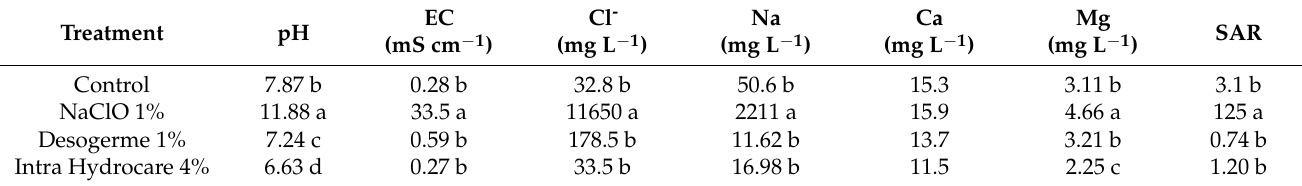
Table 3. Mean values of the pH; electrical conductivity (EC); concentrations of chloride (Cl − ), sodium (Na), calcium (Ca) and magnesium (Mg); and sodium adsorption ratio (SAR) of the irrigation water, which was untreated (control) or treated with NaClO 1%, Desogerme 1% or Intra Hydrocare 4%. In each column, values followed by the same letter did not significantly differ by LSD test ( α =